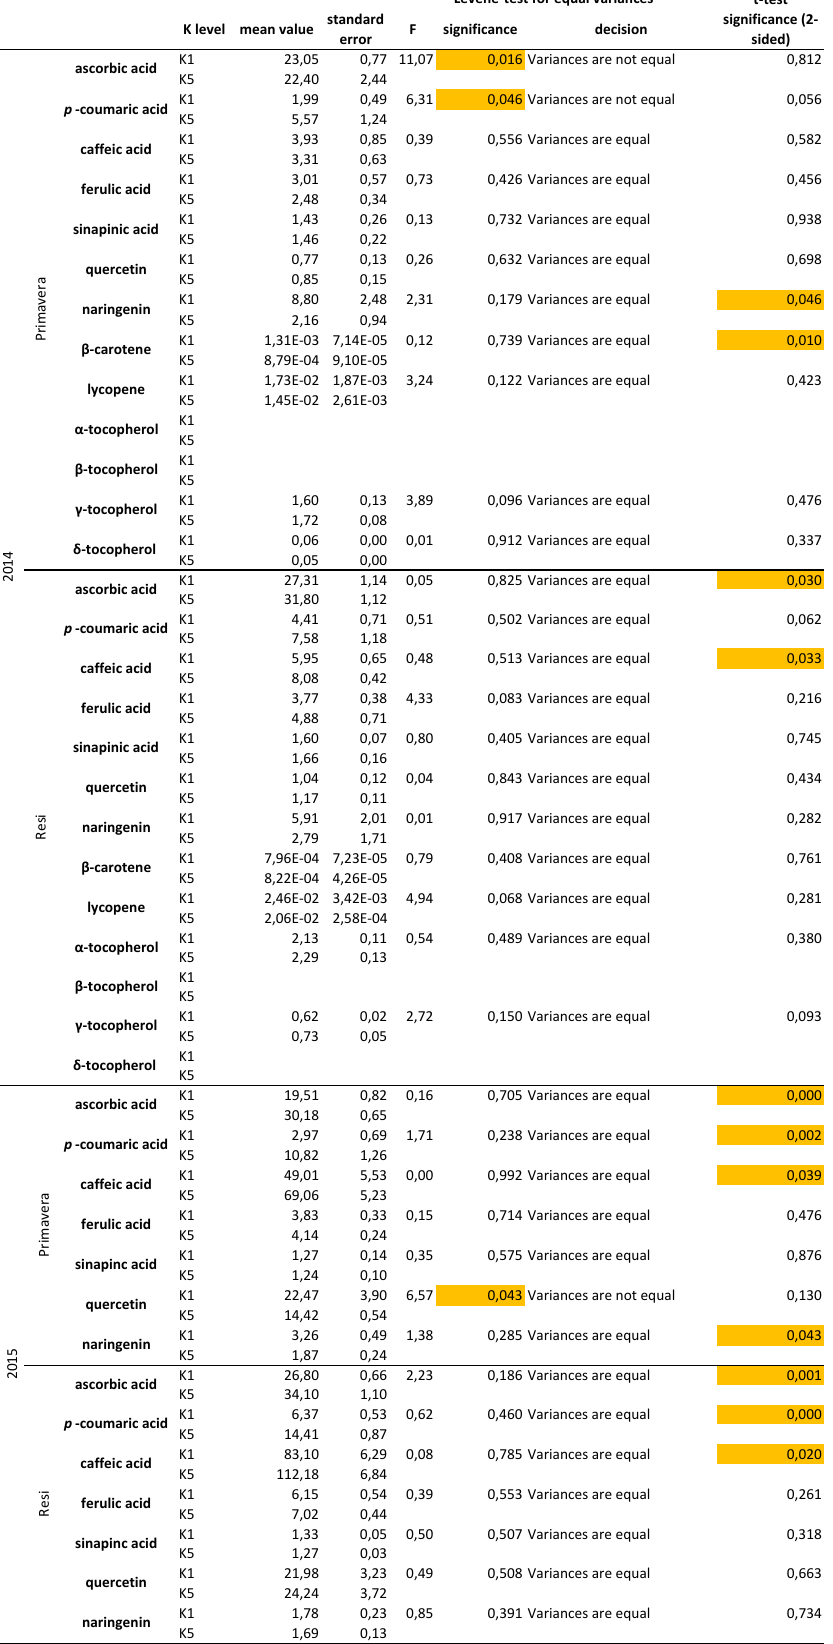
Levene-test for equal variances